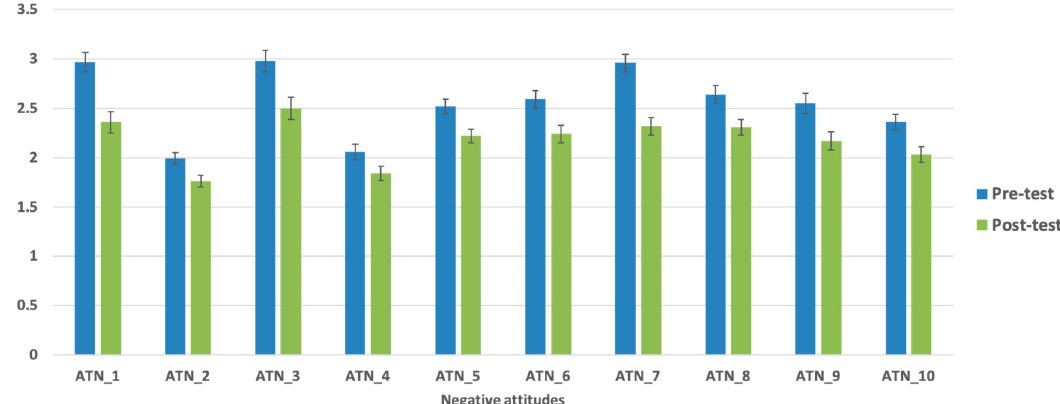
Figure 5. Mean values of the scores given for the pre- and post-test questionnaire by the 143 participants for the negative attitudes (ATN) of the PSTs toward mathematics learning by the flipped-OCN method.